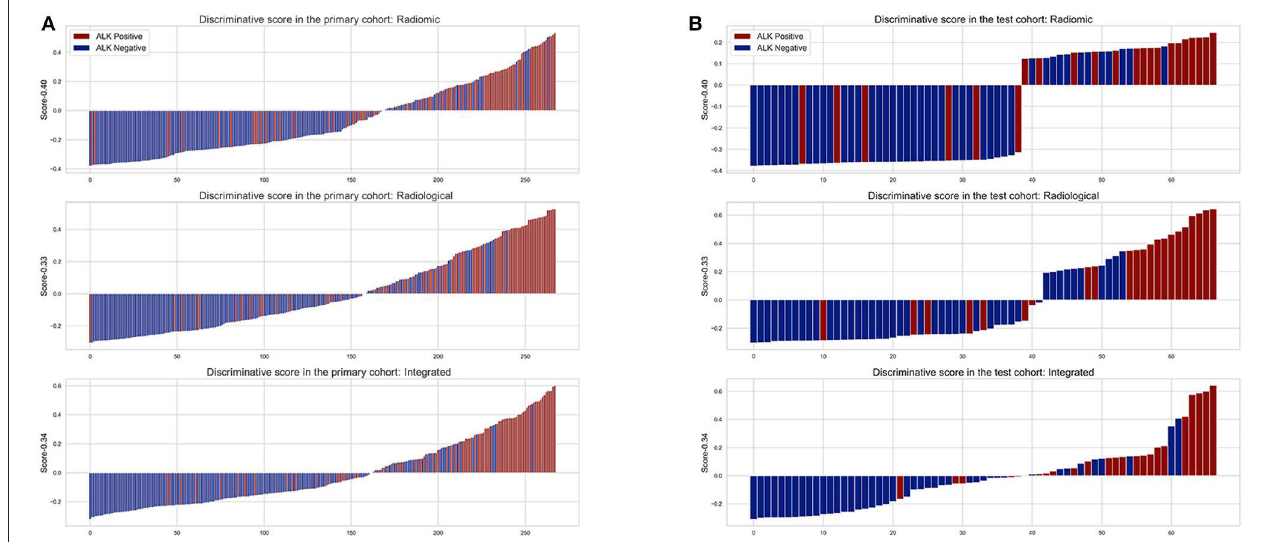
FIGURE 7 | The discriminative scores of the three predictive models in the primary (A) and test cohort (B) . The discriminative score for each patient is the average of the final predictive probabilities in the LR and DT classifier. The columns above the horizontal axis represent tumors that were predicted to be ALK + , while the columns below the horizontal axis represent the opposite. The color indicates the golden truth of each